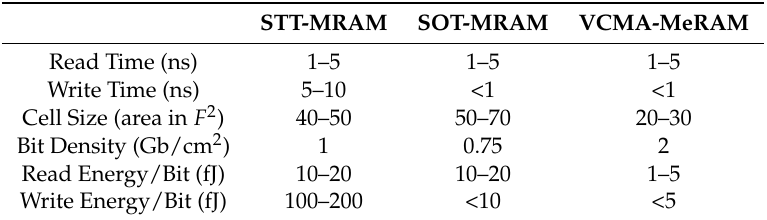
Table 1. Comparison between some MTJ-based memories.